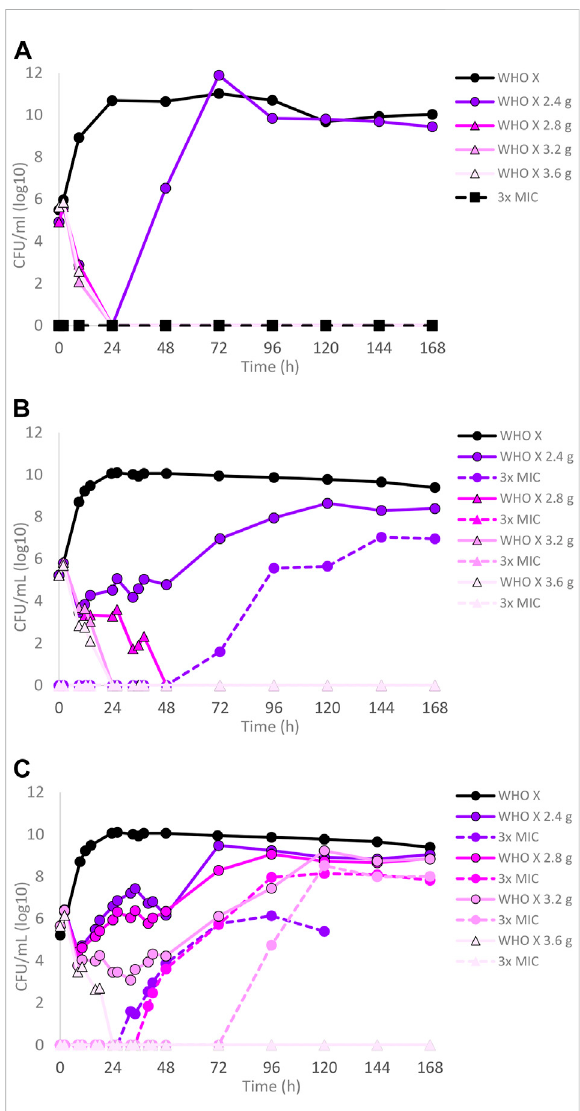
gonorrhoeae reference strains in the dose – range hollow fi ber infection model (HFIM) experiments simulating free (12% protein- unbound)lefamulinsingleoraldoseof (A) 0.4 – 1.6 g(WHOF), (B) 1.6 – 3.6 g (WHO X), and (C) 4.0 – 10.0 g (WHO V) and followed for 7 days. The total growth of the untreated control (black solid line) and total growth of lefamulin-resistant populations (dashed lines) on the lefamulin-containing plates (3 ×MIC) are also shown for each treatment. It is to be noted that lefamulin-resistant subpopulations only emerged for some failed treatments for WHO X.